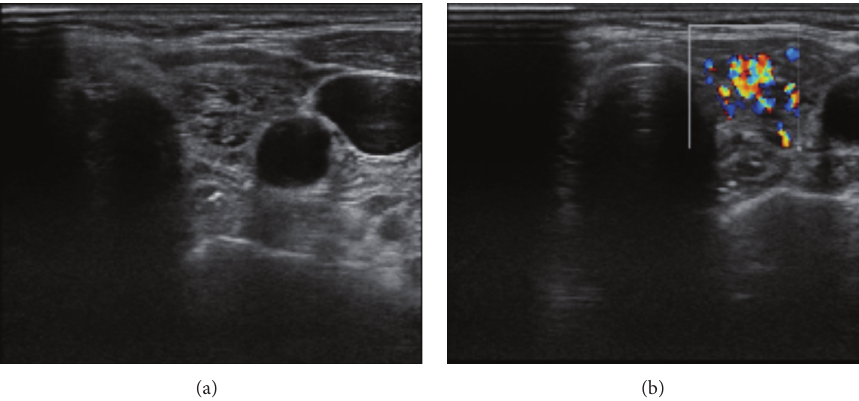
Figure 2: Ultrasonography of the left lobe. The remaining thyroid gland had an inhomogeneous appearance. There were no tumors in the left gland. Doppler color flow revealed a high vascularity in the remaining thyroid